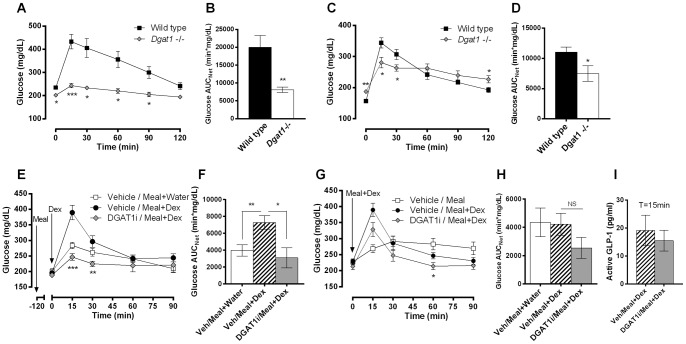
Body weight and food intake of gKD mice on HFD.Male gKD mice and wild type littermate raised no normal chow diet were switched to HFD at 4 months of age, and (A) body weight and (B) food intake were monitored for 8 weeks. No statistical significant difference was observed. N = 17–18.